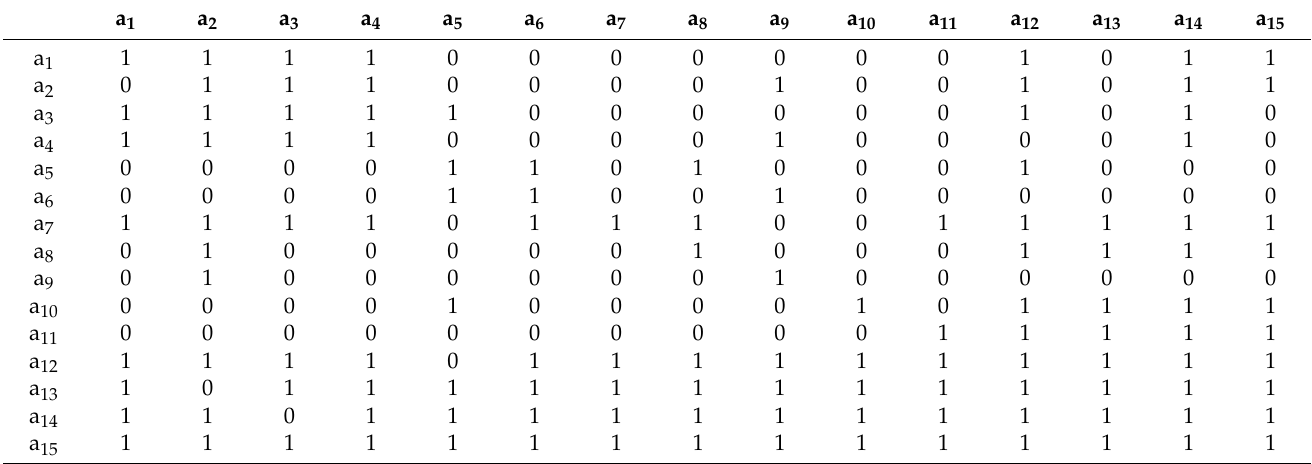
Table 5. Reachability matrix N.